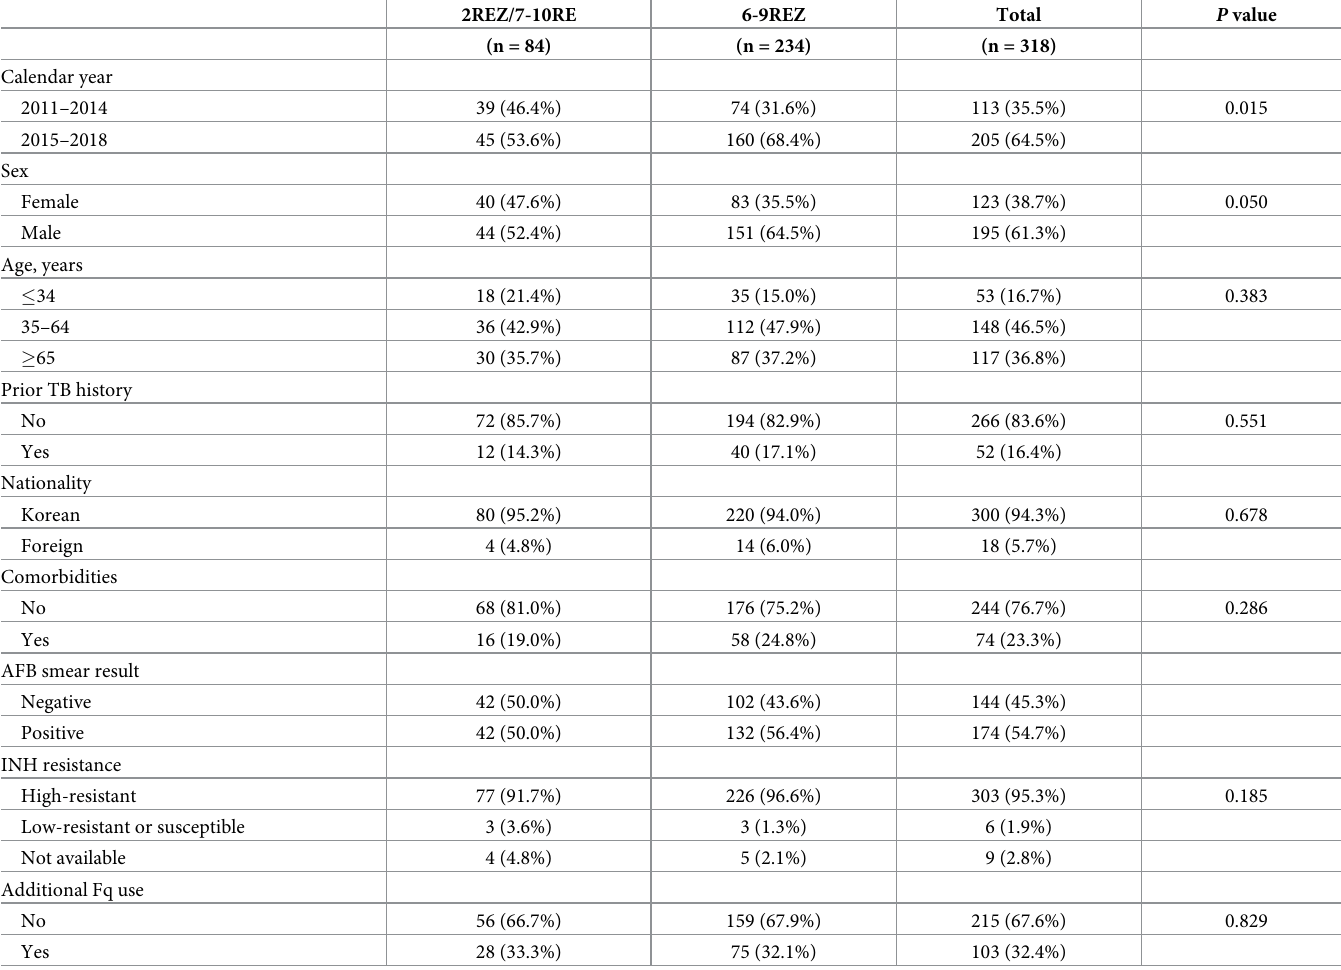
Table 1. Baseline characteristics of 318 enrolled pulmonary tuberculosis patients with isoniazid-resistant rifampicin-susceptible strain stratified by different types of initial baseline